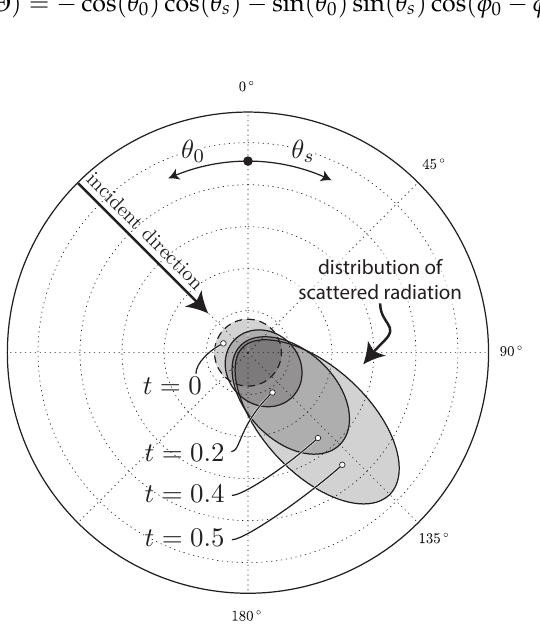
Figure 2. Illustration of HG ( t , Θ )